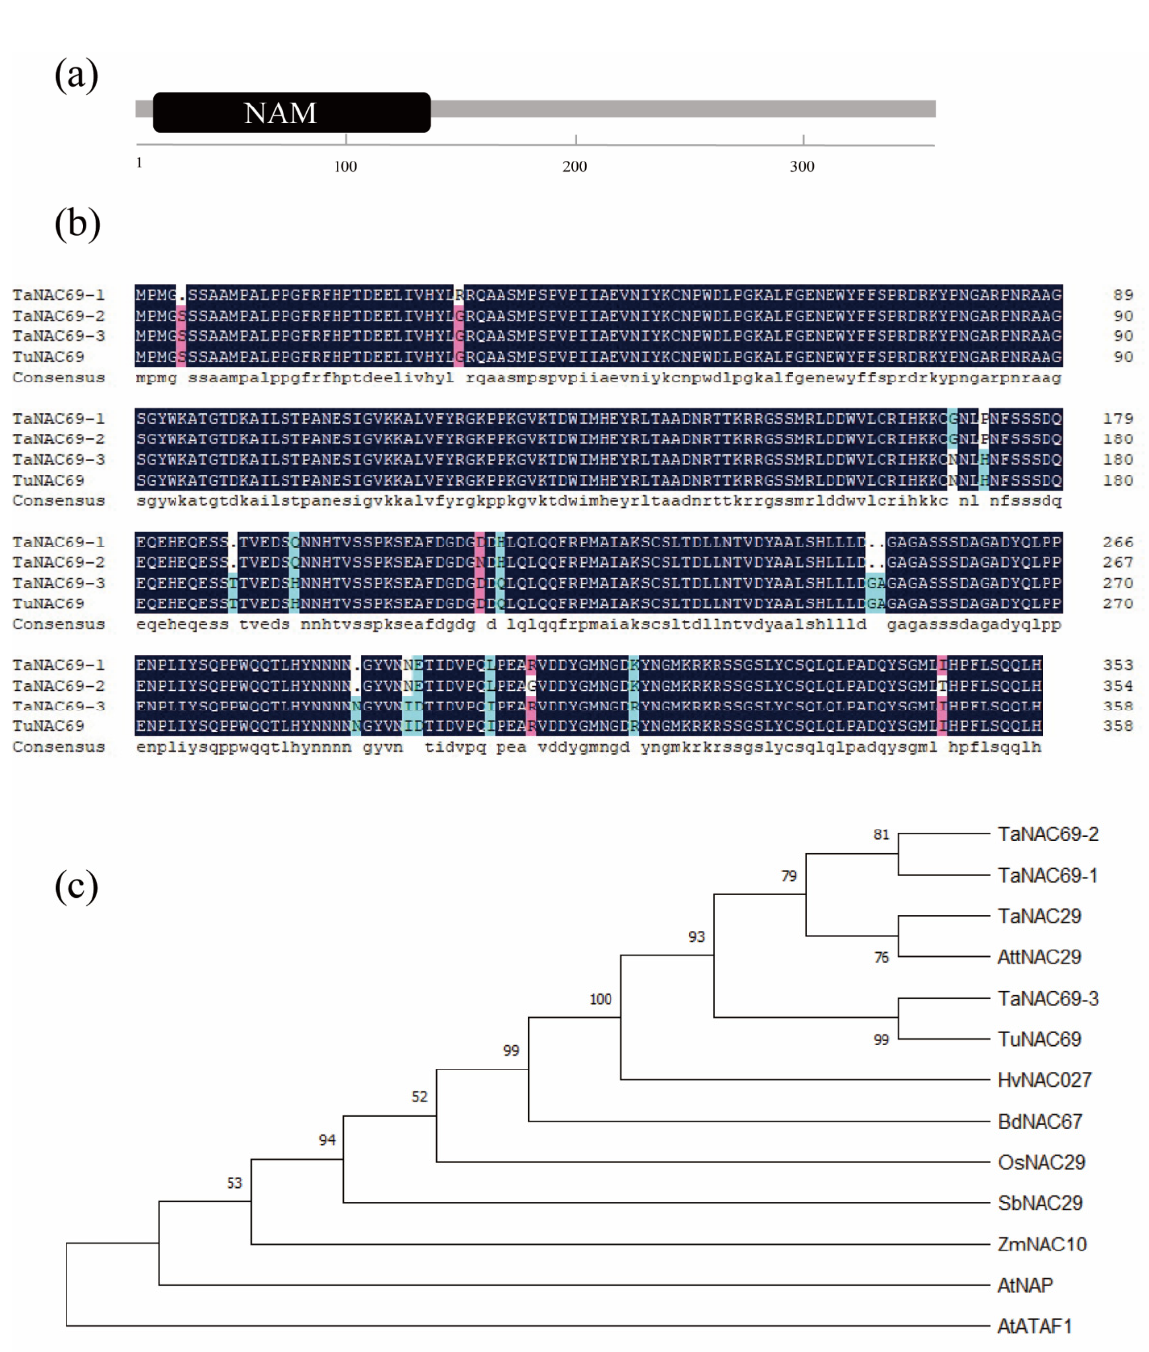
Figure 2. Analysis of TuNAC69. ( a ) Schematic representation of TuNAC69 protein domain. ( b ) Multiple comparisons between TuNAC69 and its homologs in wheat. ( c ) Phylogenetic analysis of TuNAC69. Different NAC transcription factors from Triticum aestivum (Ta), Hordeum vulgare subsp. Vulgare (Hv), Aegilops tauschii subsp. tauschii (Att), Sorghum bicolour (Sb), Zea mays (Zm), Brachypodium distachyon (Bd) and Arabidopsis thaliana (At) were used for the phylogenetic analyses. The unrooted phylogenetic tree was depicted using the MEGA X program and was constructed using the neighbor ‐ joining method. TaNAC69 ‐ 1 (AAU08785.1), TaNAC69 ‐ 2 (XP_037440448.1), TaNAC69 ‐ 3 (AAY44098.1), HvNAC027 (CBZ39285.1), TaNAC29 (AKC34071.1), OsNAC29 (XP_015615093.1), AttNAC29 (XP_020166974.1), AtNAP (NP_564966.1), AtATAF1 (NP_171677.1), BdNAC67 (XP_003577115.1), SbNAC29 (XP_002448919.1), ZmNAC10 (PWZ45967.1) .